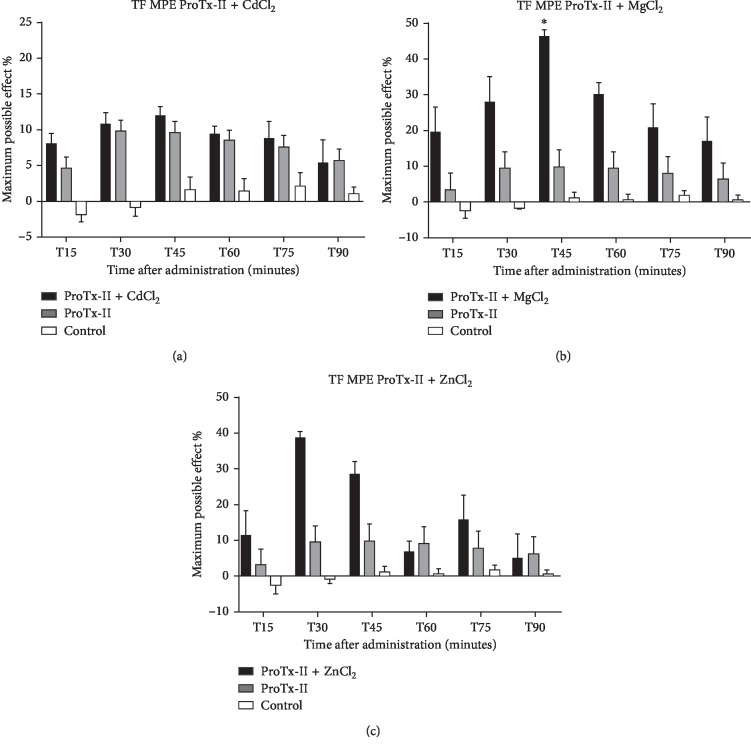
The maximum possible effect over the tail-flick test expressed in % and represented as mean ± SEM over a period of 90 minutes. Significant difference from the control groups was noted with ∗ for a p value < 0.05. (a) Protoxin-II and CdCl2 with Protoxin-II as positive control and saline as negative control. (b) Protoxin-II and MgCl2 with Protoxin-II as positive control and saline as negative control. (c) Protoxin-II and ZnCl2 with Protoxin-II as positive control and saline as negative control.